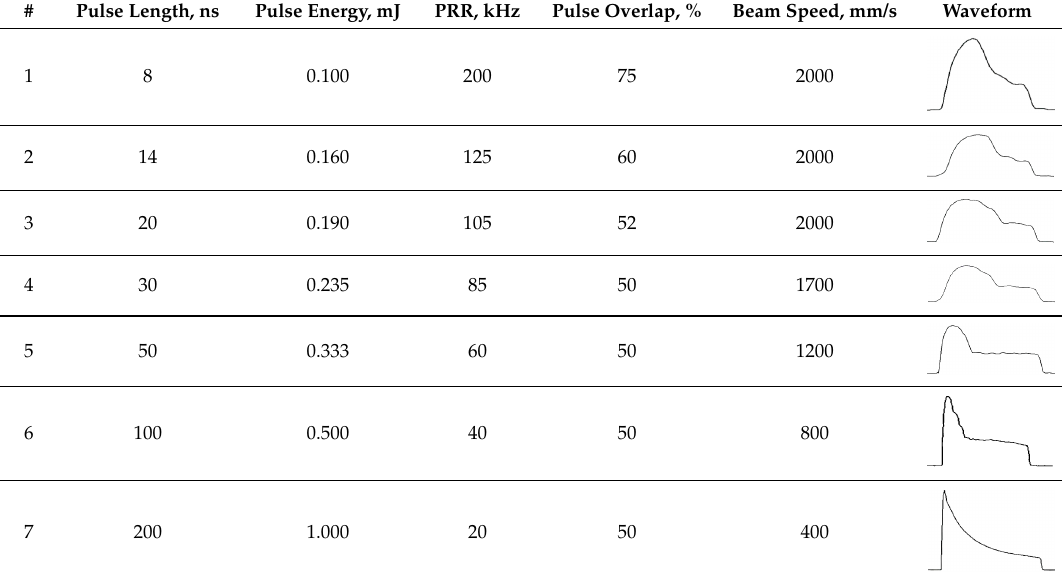
Table 3. Used laser parameters and waveforms for the experiments. PRR: pulse repetition rates.